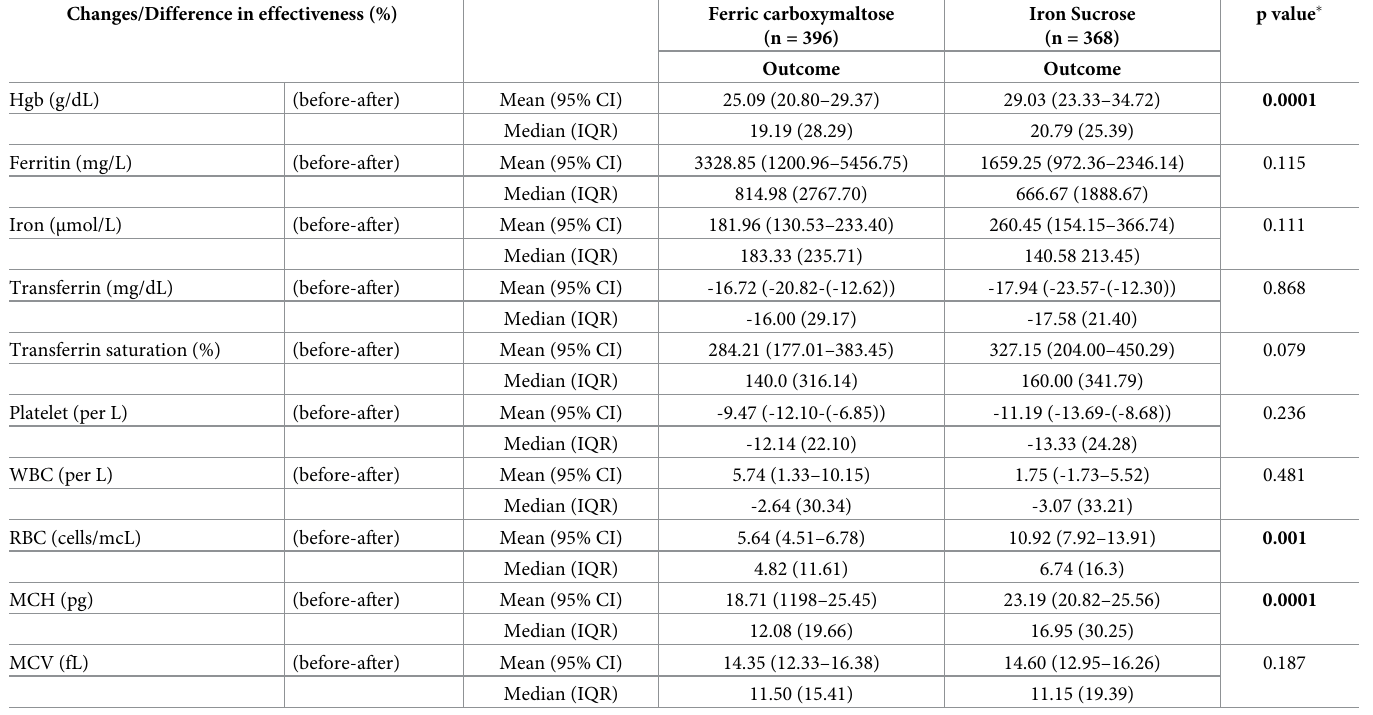
Note: % difference or change = [(after treatment–before treatment)/before treatment] x